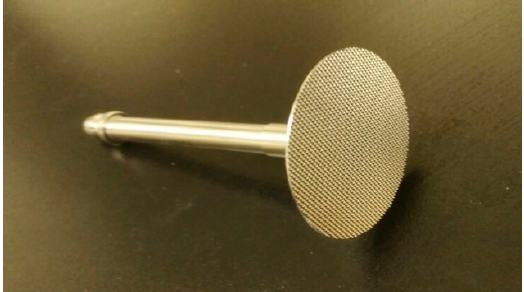
Figure 2. Picture of spindle.